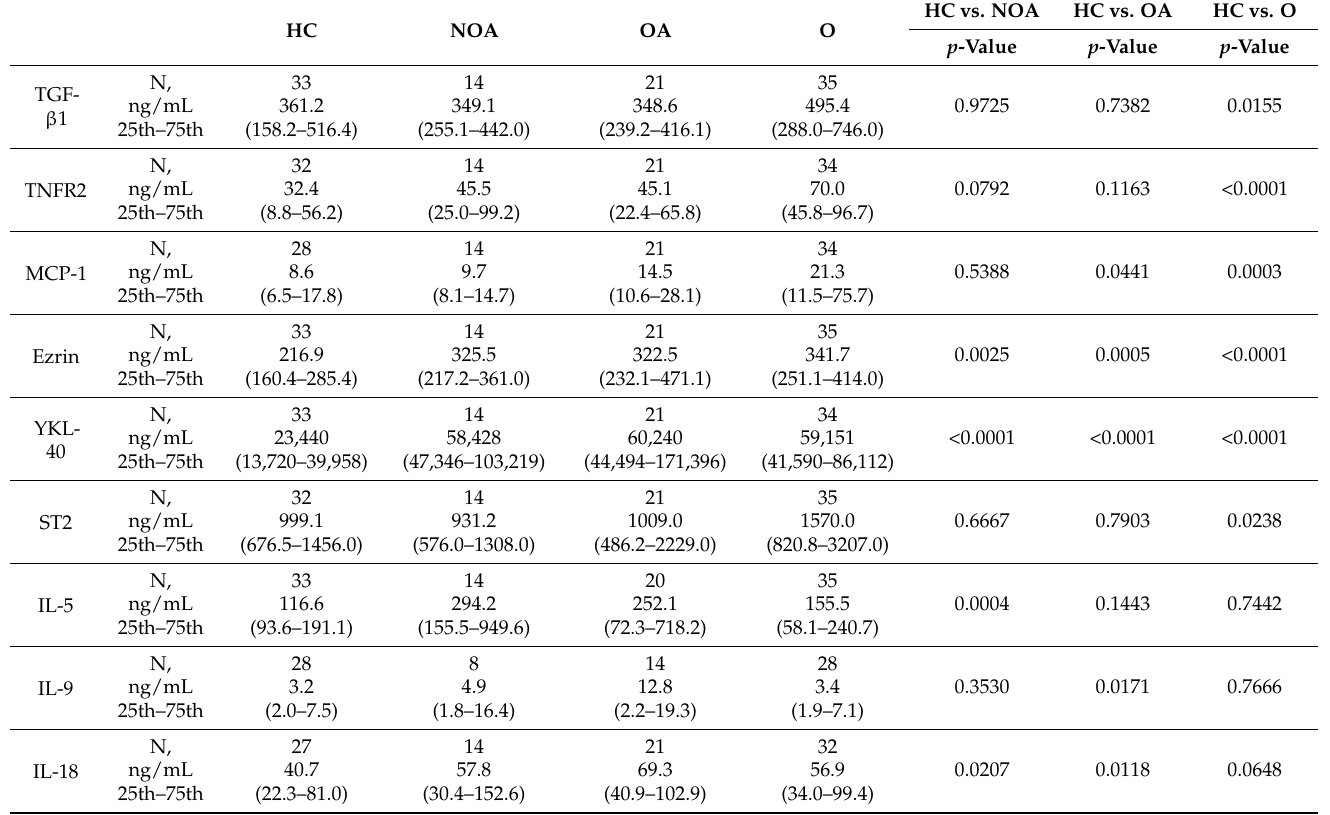
Table 3. Serum cytokine level comparison of non-obese asthmatics, obese asthmatics, and obese subjects with healthy